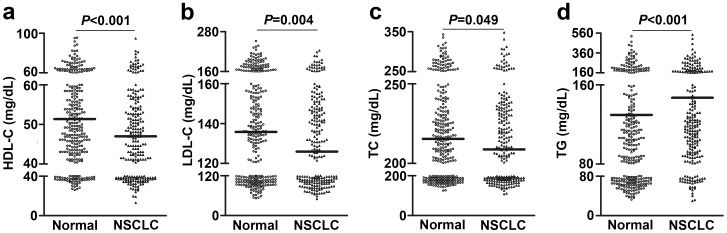
Pre-therapy serum levels of lipids in patients with NSCLC and in healthy controls.Pre-therapy serum levels of HDL-C (a), LDL-C (b), TC (c), and TG (d) in NSCLC and healthy controls. Each dot represents the lipid level from one patient or one control, and the line in the graph indicates the median value.